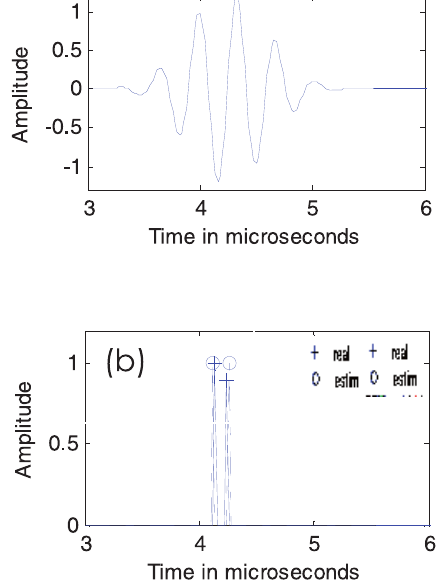
Fig. 4. (a) Closely echoes with noise free. (b) Deconvolution echoes for